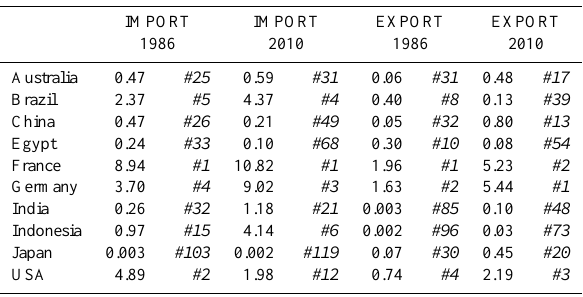
Fig. 3. Zoom on Europe for the net flux of virtual water (import minus export) of Italy in 2010.